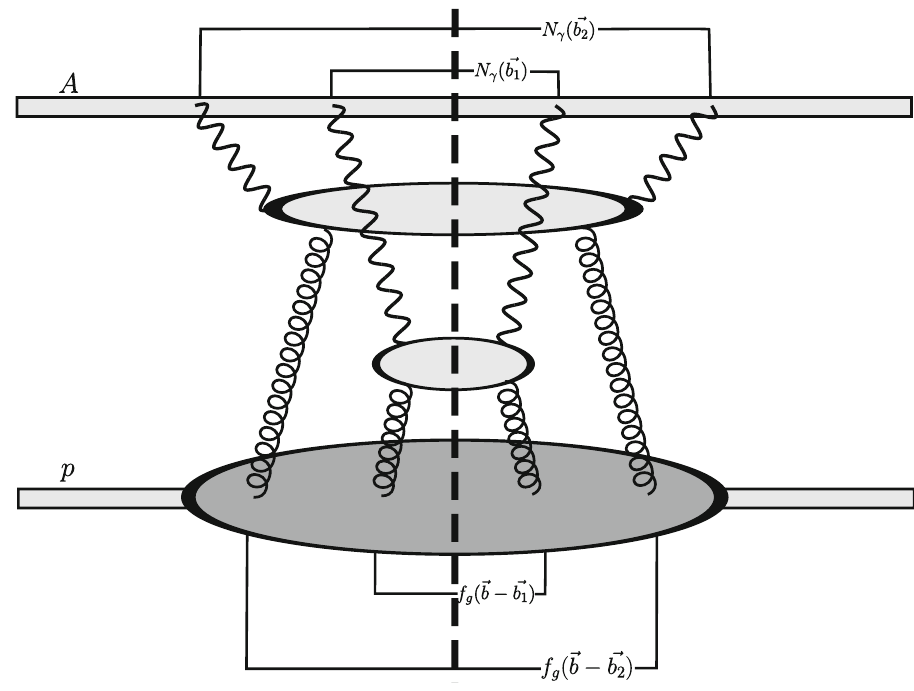
Fig. 1 A schematic illustration of the A + p → A + ( c ¯ cb ¯ b ) + X cross section in pA